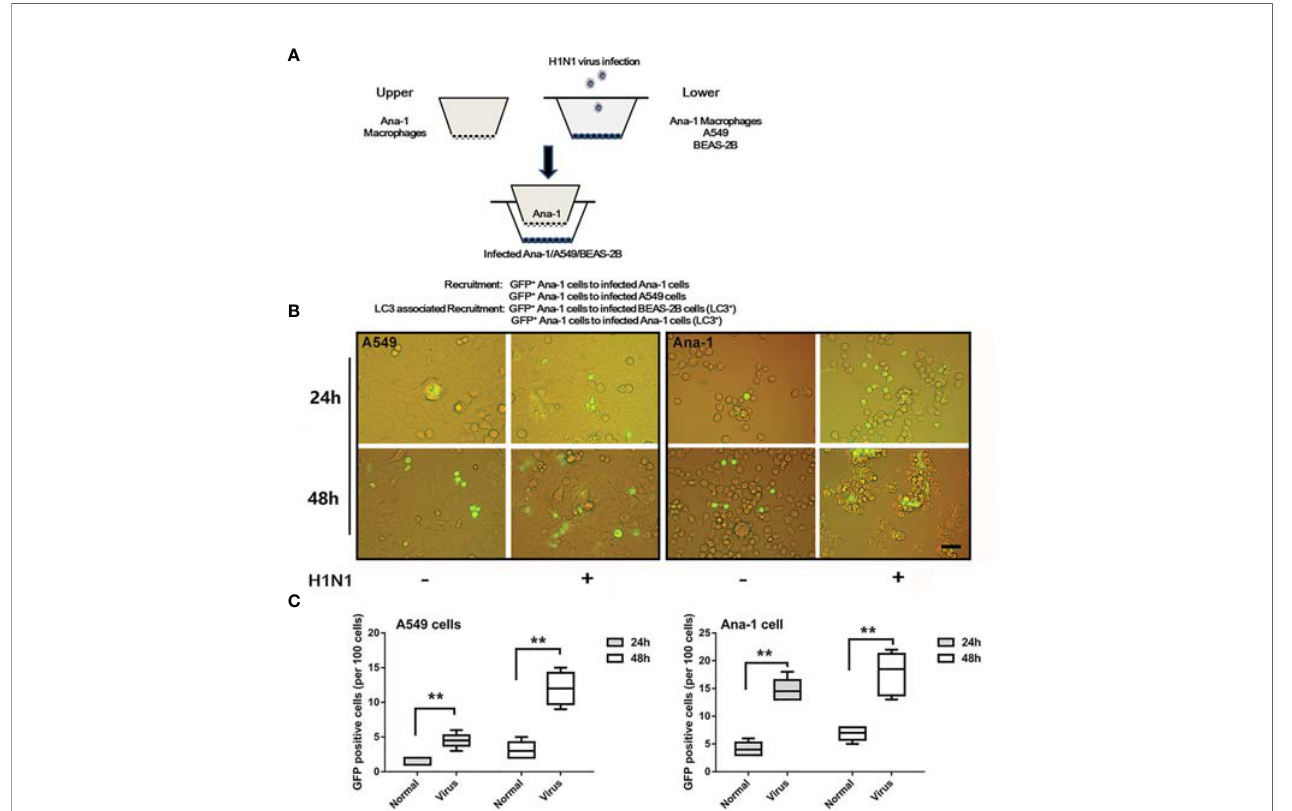
FIGURE 2 | Macrophage recruitment in in-vitro infection experiments. (A) A systematic study of macrophage recruitment using 24-well transwell chambers (8.0- m M membrane). (B) GFP + ANA-1 recruitment in transwell assays. GFP + macrophages were inoculated into the upper chambers, while A549 cells or ANA-1 macrophages were inoculated into the lower chambers and infected with in fl uenza PR/8/34. Scale bar: 30 m m. (C) The GFP + ANA-1 macrophages in the lower chambers were enumerated to evaluate the extent of trans-membrane recruitment of macrophages. No fewer than three fl uorescent images were captured and analyzed per group. ** p <